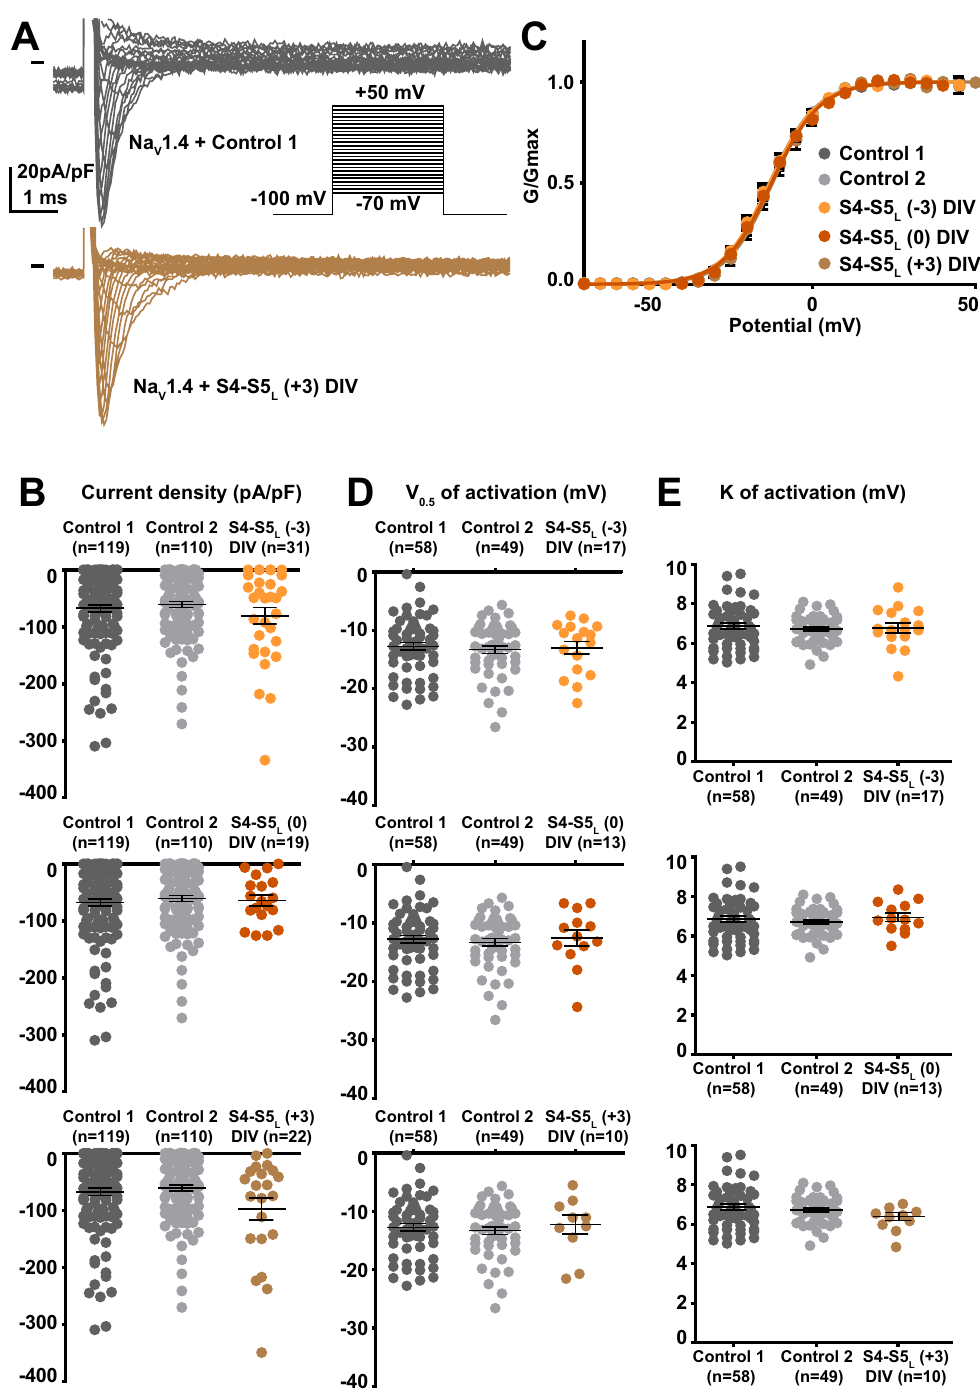
Figure 8. Effect of Na V 1.4 S4-S5 L mimicking peptides of domain IV on Na V 1.4 current density and activation curve. ( A ) representative, superimposed current recordings in COS-7 cells co-transfected with Na V 1.4, Na V ß1, and control 1 (top trace) or domain IV S4-S5 L ( + 3) peptide (bottom trace). Inset: activation voltage protocol used (holding potential: − 100 mV; 30-ms pulse; one sweep every 2 s). ( B ) Dot plot and mean ± sem of peak Na V 1.4 current densities recorded in COS-7 cells co-transfected with Na V 1.4, Na V ß1, and the indicated peptide, at 0 mV. ( C ) Relative peak conductance versus membrane potential curves for Na V 1.4 channels in the same cell groups as in ( B ). Lines are Boltzmann fits to the data. ( D , E ) Dot plot and mean ± sem of Na V 1.4 half-activation potential (V 0.5 ; D ) and activation slope (K; E ) in the same cells group as in ( B